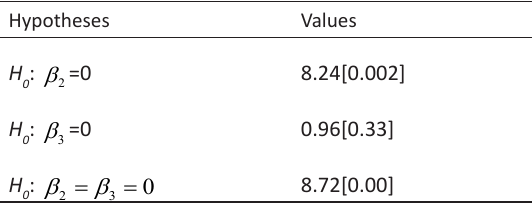
Table 5. Test results for